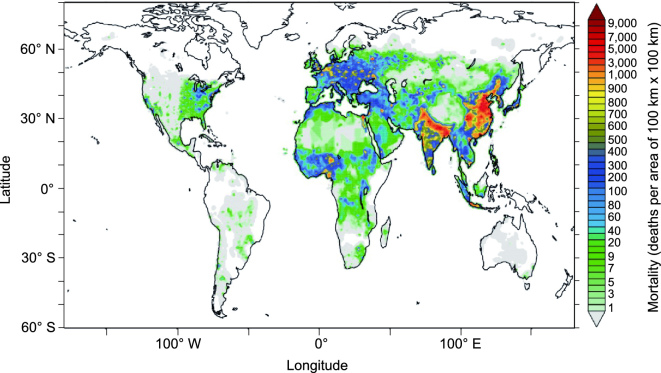
The contribution of outdoor air pollution sources to premature mortality on a global scale. The data were derived from a global atmospheric chemistry model that links premature mortality to outdoor air pollution, mostly by PM2.5. Study found that, in 2010, outdoor air pollution, mostly by PM2.5, leads to 3.3 million premature deaths per year worldwide, predominantly in Asia. Unit of mortality was expressed as deaths per area of 100 km × 100 km (color-coded). In the white areas, annual mean PM2.5 and O3 are below the concentration–response thresholds where no excess mortality is expected. The figure was originally published by [14] and has been approved for reuse by Nature Publishing Group.